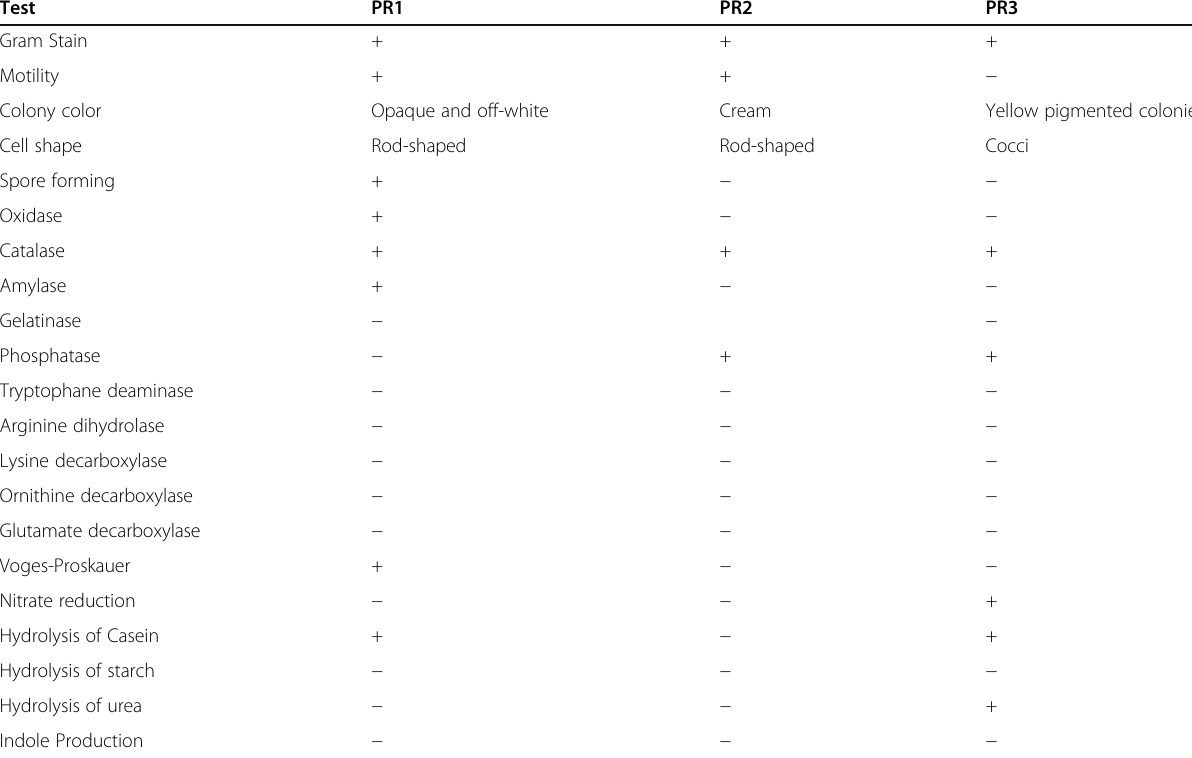
Table 6 The morphological and biochemical characterization of bacterial isolates